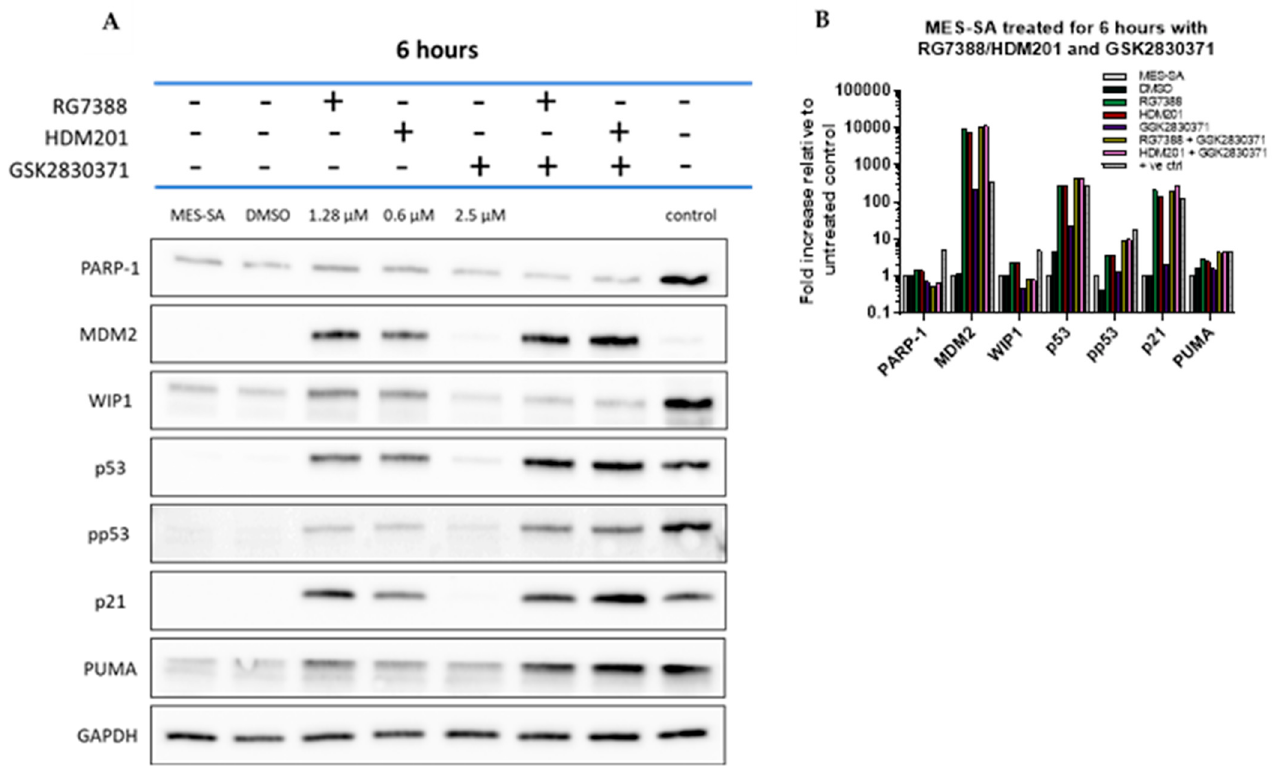
Figure 4. ( A ) Western immunoblot of MES-SA cells treated for 6 h with RG7388, HDM201 and GSK2830371. The positive control was SH5Y5Y cells collected 2 h post 4 Gy X-irradiation (provided by A. Yagbasan). GAPDH was used as the load- ing control. Doses of RG7388 and HDM201 represent 10 × their GI concentrations. All strips were from the same mem- 50 brane which was cut into three. The top strip was probed for WIP1, MDM2 and PARP-1; the second for pp53, p53 and GAPDH; and the third PUMA and p21. ( B ) Densitometry, with values background corrected, normalised to GAPDH, then fold change expressed relative to untreated